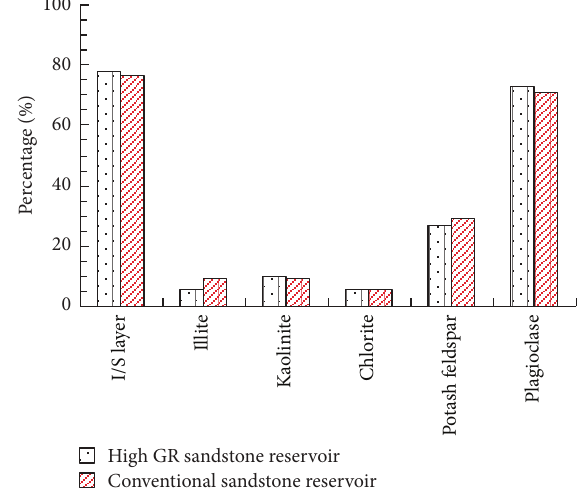
Figure 2: The feldspar and clay mineral types for high GR sandstone reservoir and conventional sandstone